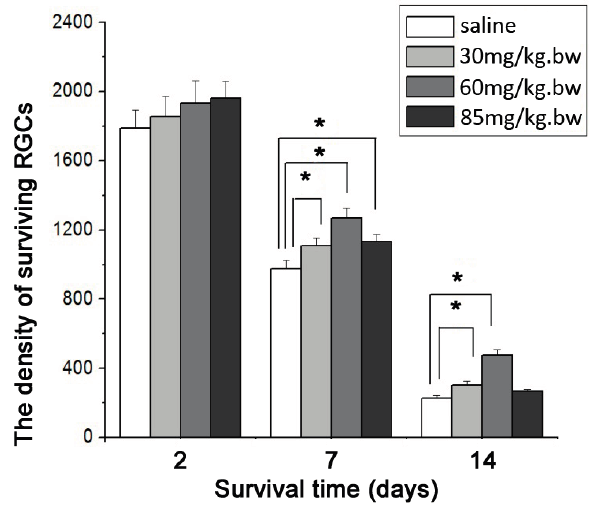
Figure 2. Histogram illustrating the mean densities of surviving RGCs in normal saline (NS)-control, 30, 60 and 85 mg/kg·bw LiCl groups ( n = 6 for each group) at three different survival time points. The asterisks indicate significantly higher RGC densities ( * p < 0.01) in LiCl groups compared with those in Control groups at 7 and 14 day time points. Error bars = S.E.M.